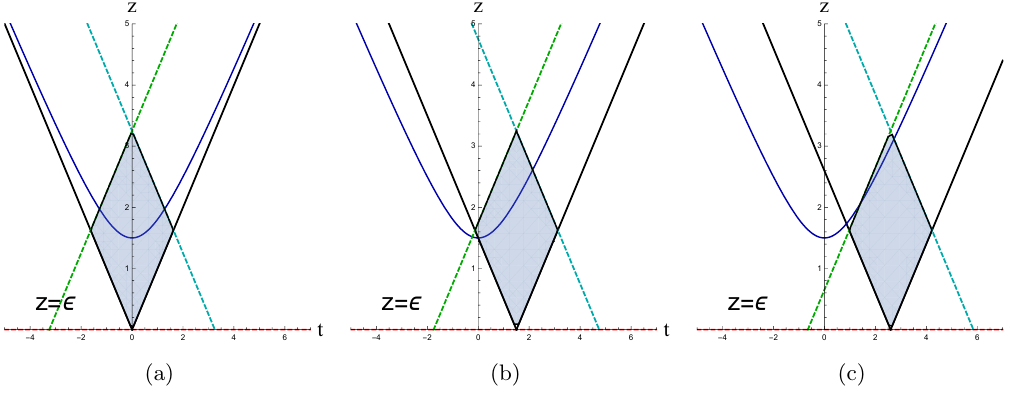
Figure 7 . Possible di(cid:11)erent con(cid:12)gurations of the WDW patch, the entanglement wedge, and the particle worldline (the blue curve). The solid region is the intersection of the WDW patch and the entanglement wedge. All plots show the case (cid:11) < ‘= 4. The left plot corresponds to the early time evolution (cid:28) < (cid:28) crit , the central plot is for (cid:28) crit < (cid:28) < (cid:28) f , and the right one is for (cid:28) > (cid:28) f